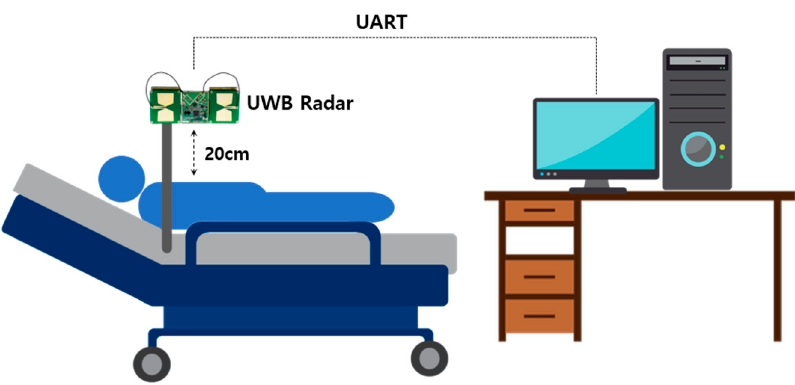
Figure 11. UWB Radar installation environment for collecting respiratory signal data.